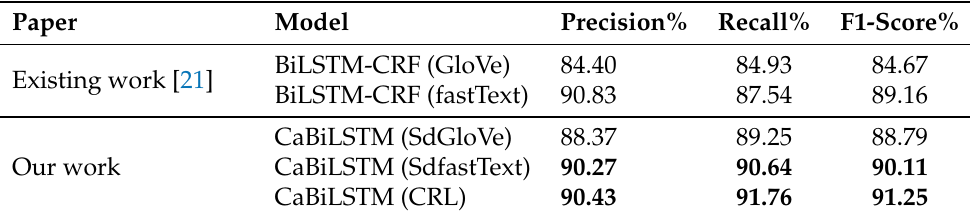
Figure 5. Label-wise F1-score of the CaBiLSTM model on the test set. Table 8. The comparison of our proposed CaBiLSTM model with the previous works on SiNER dataset using SdGloVe and SdfastText representations. Bold font denotes the best